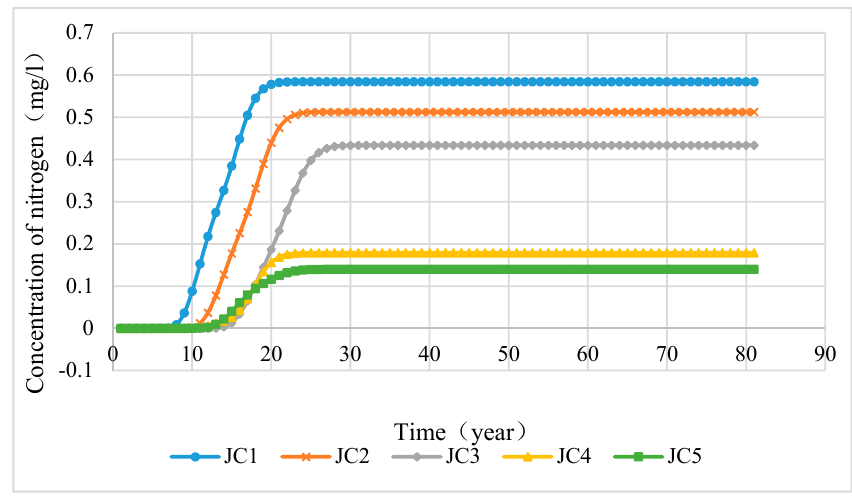
Figure 13. Ammonia nitrogen concentration changing curves of five monitoring wells with strong pumping.